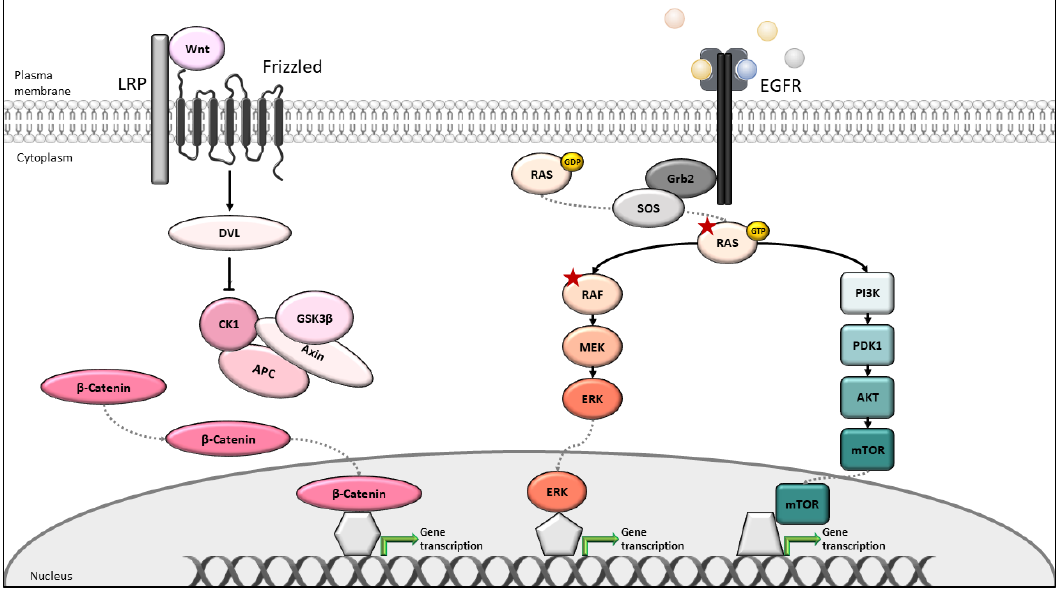
Figure 1. Schematic illustration of the canonical Wnt/β-catenin, RAS-ERK, and PI3K/AKT/mTOR signaling pathways. In the presence of extracellular Wnt ligands, the β-Catenin degradation complex is inhibited and β-Catenin translocates to the nucleus, resulting in the activation of the target genes. Additionally, Wnt can affect the RAF-MEK-ERK signaling through the stabilization of the RAS proteins. The RAS-ERK route is stimulated through the binding of EGF to EGFR, which then allows SOS to activate RAS by exchanging GDP to GTP. GTP-bound RAS is necessary for the activation of RAF and the signal is propagated to MEK-ERK kinase, via phosphorylation. Phosphorylated ERK translocates to the nucleus and activates various transcription factors. Activated PI3K, an additional RAS target, results in the activation of PDK1 and AKT. AKT signaling, in turn activates mTOR, leading to the expression of target genes. Red asterisks indicate the gain of the function mutation, © Silvia Eller.